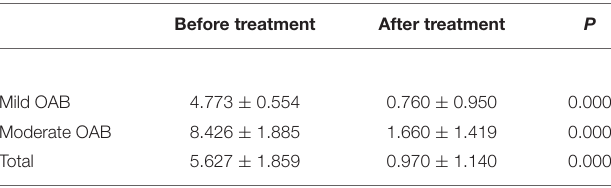
TABLE 4 | Comparison of the OABSS scores before and after treatment of desloratadine in children with OAB. Before treatment After